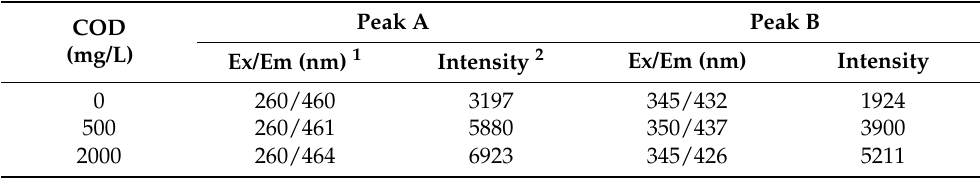
Table 3. Fluorescence spectral parameters of SMP in the effluent of the MBR. Peak A Peak COD (mg/L)